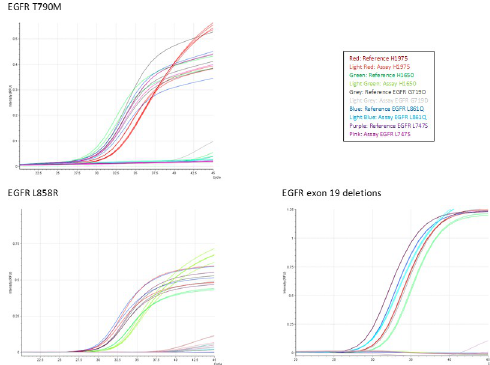
Fig 3. Assessment of platform specificity. PCR curves obtained when challenging assays with cell lines or plasmids containing the indicated EGFR mutations. Plasmids were diluted 1:1 in WT gDNA to ensure a total template amount of 1600 copies. Reference assay PCR curves are represented by heavy coloured lines and mutation specific assay PCR curves by light coloured lines as indicated in figure legends. Abbreviations: Ct, Cycle threshold; EGFR, Epidermal growth factor receptor.